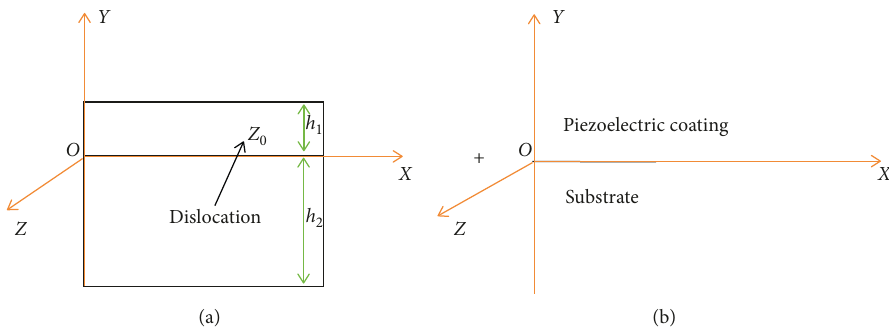
Figure 2: Superposition scheme: (a) a screw dislocation near interface of the fine-grained piezoelectric coating/substrate; (b) an edge interfacial crack of the half semi-infinite plane piezoelectric bimaterials.